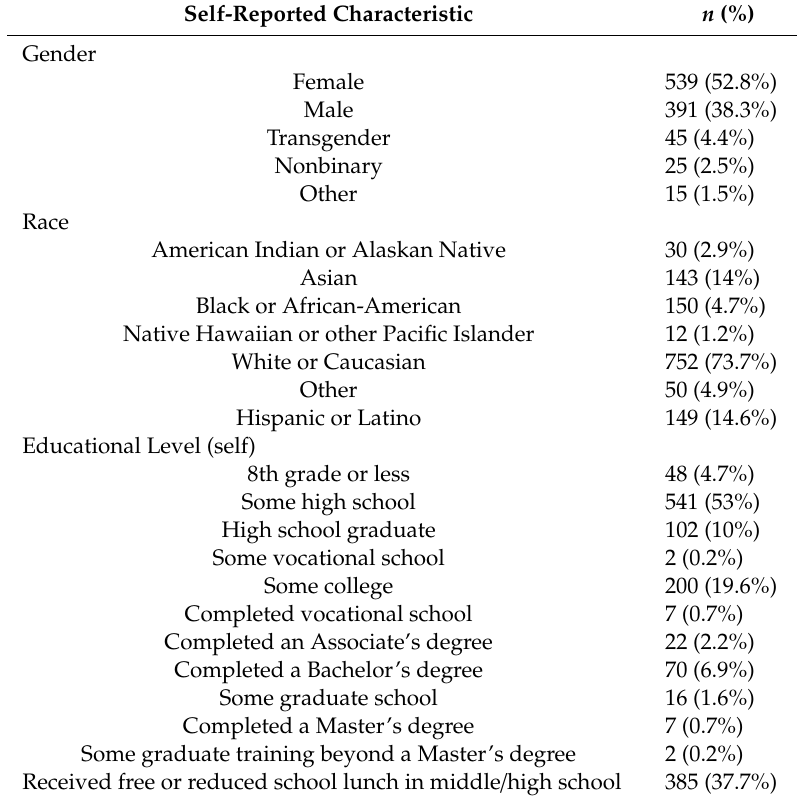
Table 1. Demographic features of